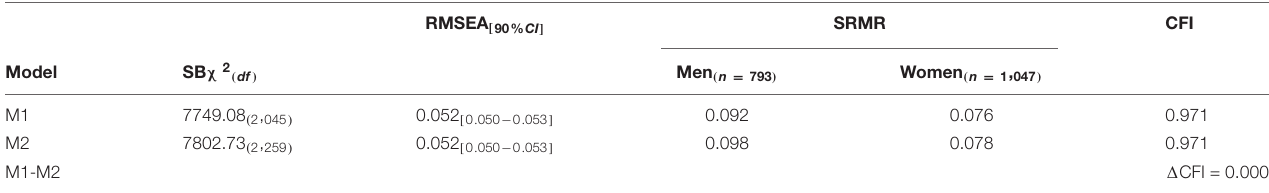
TABLE 5 | Regression model of the effect of determinants of major choice on academic expectations: invariance across gender.